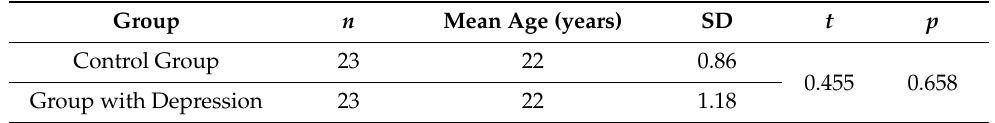
Table 1. Average age ( ± SD) in the group without depression (control group) and the group with depression.